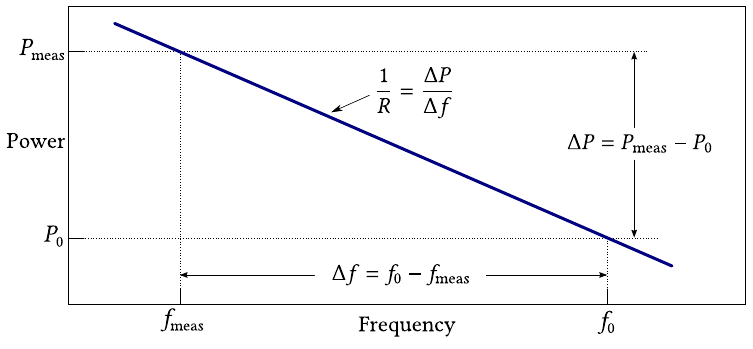
Figure 13. Frequency droop characteristic.